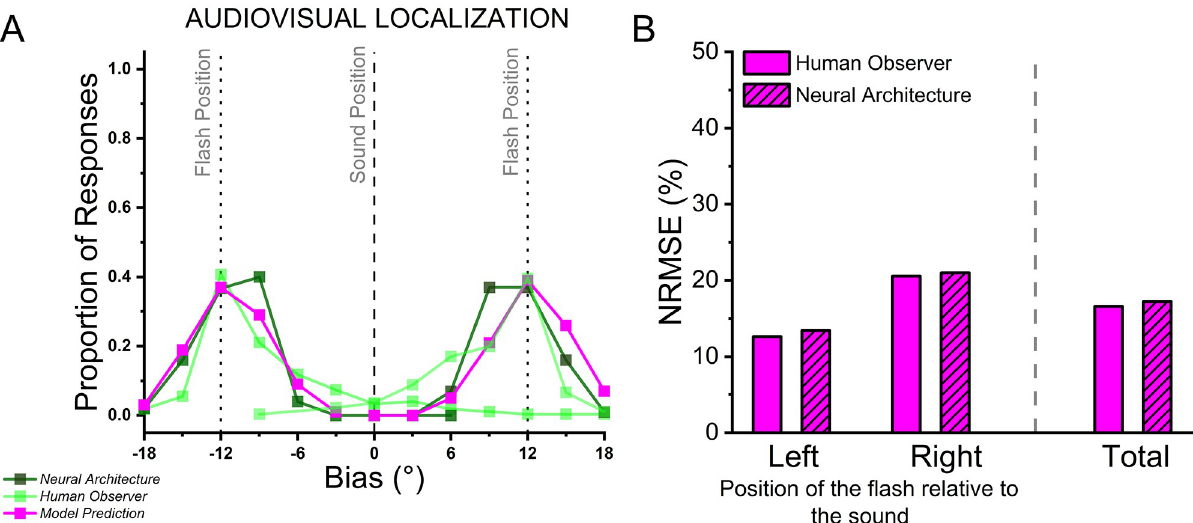
Fig 5. A) Performance of the optimal Bayesian observer (magenta line and points) compared with performance of the averaged human observer (light green) and the neural architecture (dark green). B) NRMSE values for the visual-left and visual-right conditions, and then reported considering the whole